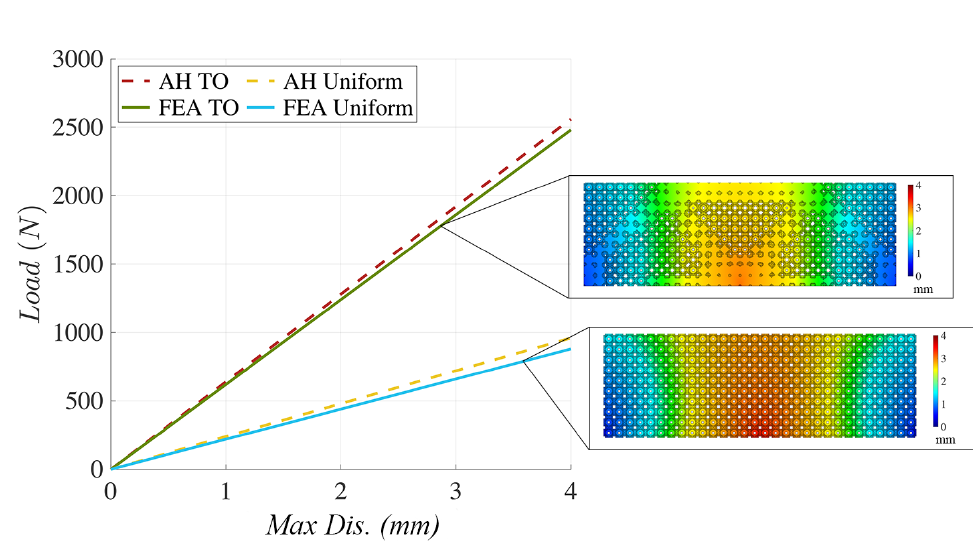
Figure 13. Max-Displacement/Load plot comparison between asymptotic homogenization and finite element analysis results for both optimized and uniform structure.